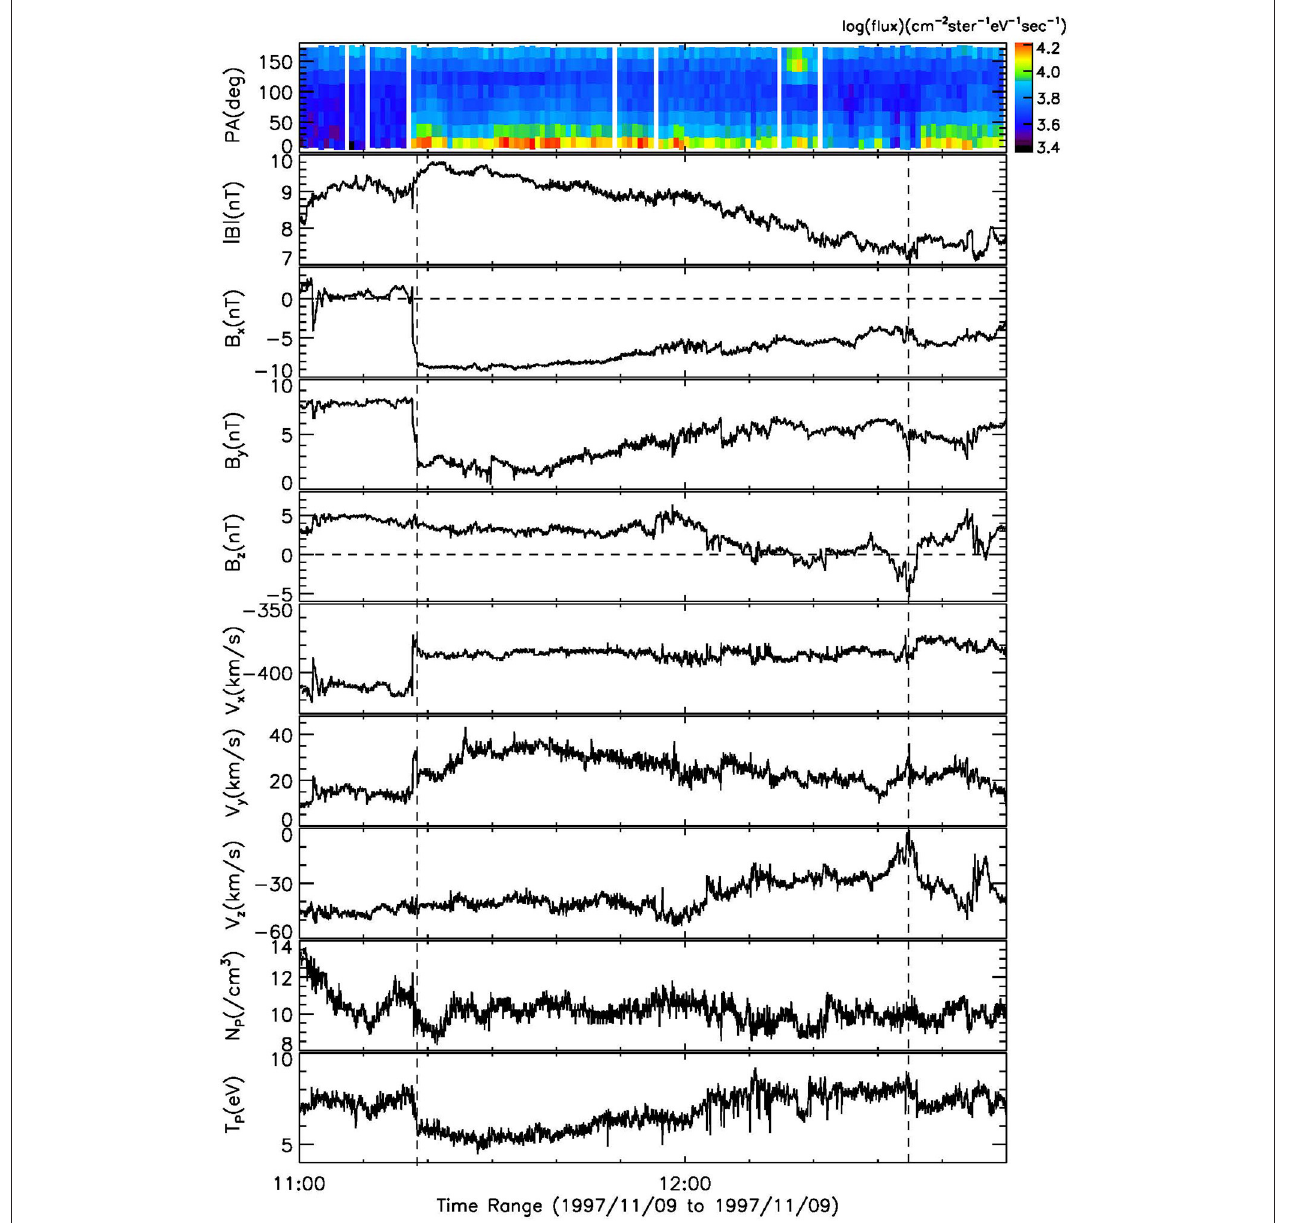
FIGURE 6 | Observations of the November 9th, 1997 flux rope passage. The format of the figure is same as Figure 1 .